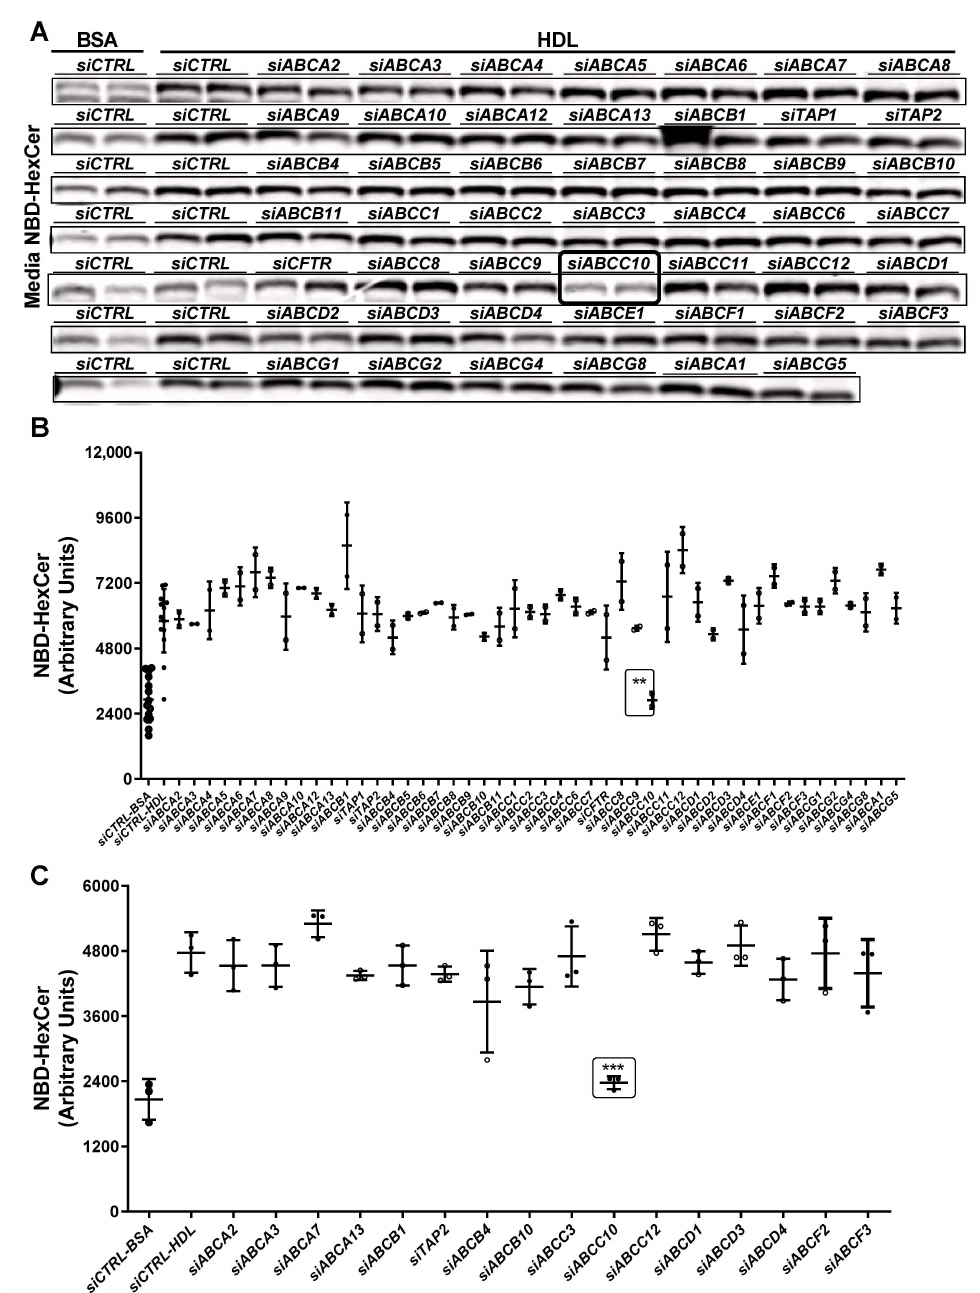
Figure 2. Identification of transporter(s) involved in HexCer egress to HDL. ( A , B ) Primary screen- ing. Huh-7 cells were transfected in duplicate with of siCTRL or siRNA against various indicated membrane transporters (50 nM). After 72 h, cells were washed and incubated with 2 µ M C6-NBD ceramides in DMEM containing 10% FBS for 3 h. Cells were washed again thrice with DMEM containing 0.1% BSA. Subsequently, cells were incubated with either BSA or HDL (40 µ g/mL) in DMEM for 6 h. Media lipids were extracted for separation by TLC. Fluorescence in HexCer bands were photographed with the PhosphorImager ( A ) and quantified using Image J and plotted ( B ). ( C ) A secondary screening for selected transporters was performed in triplicate. Values are replicates (Mean ± SD), ** p < 0.01 and *** p < 0.001 compared with siCTRL-HDL